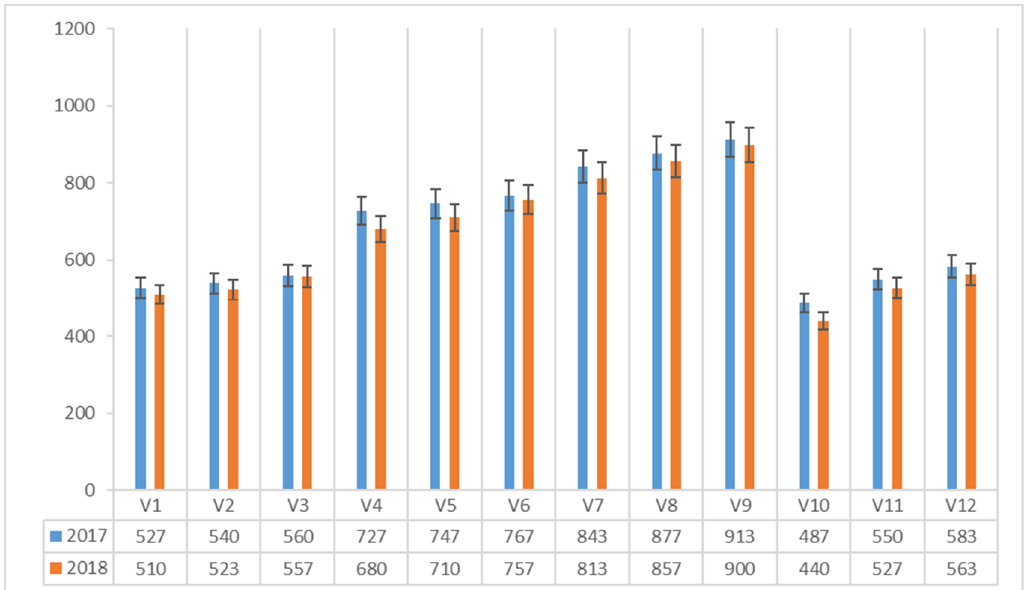
Figure 6. Vitamin B 12 content of Agaricus blazei Murrill mushrooms (μg 100g −1 dm) in two years of experiments.